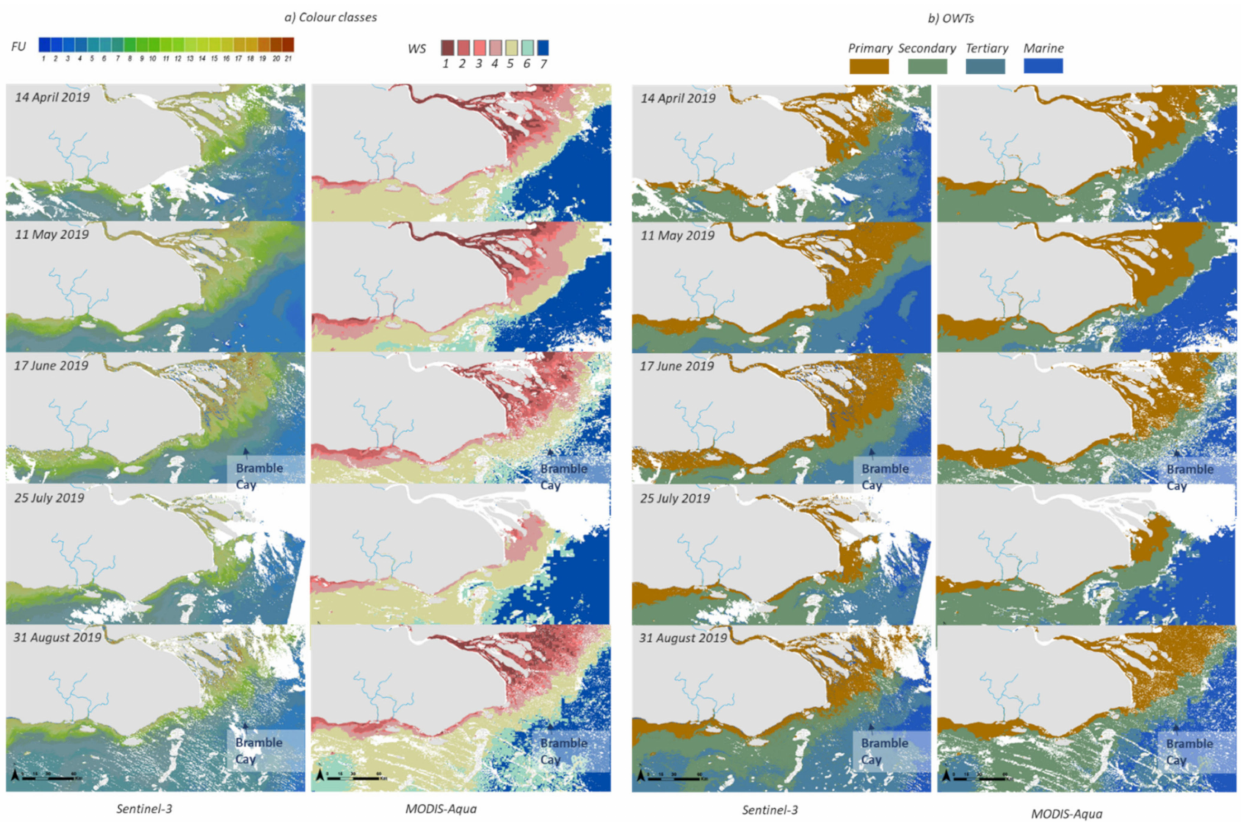
Figure 2. Examples of ( a ) colour class and ( b ) OWT maps produced with the Forel-Ule (FU) and Wet Season (WS) colour scales applied on Sentinel-3 and MODIS-Aqua optical imagery,